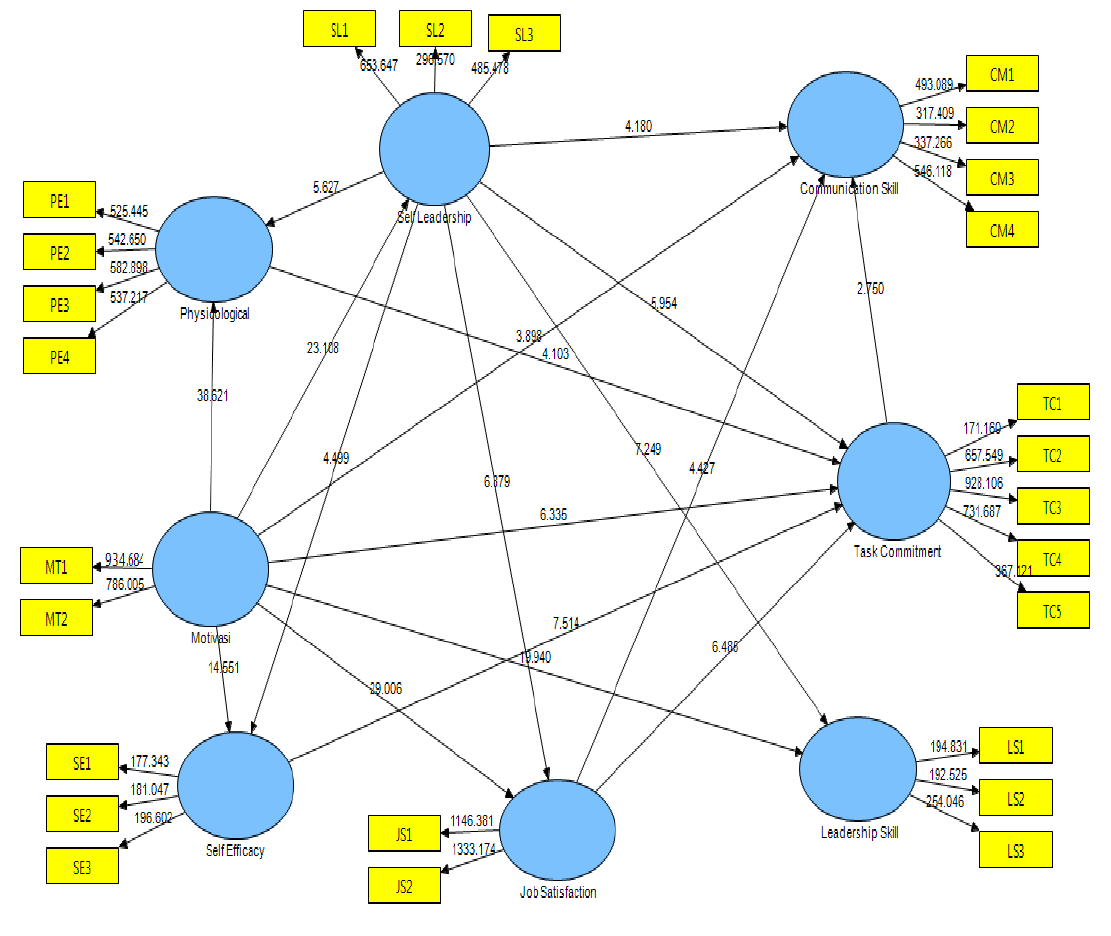
Figure 1. Finale Inner